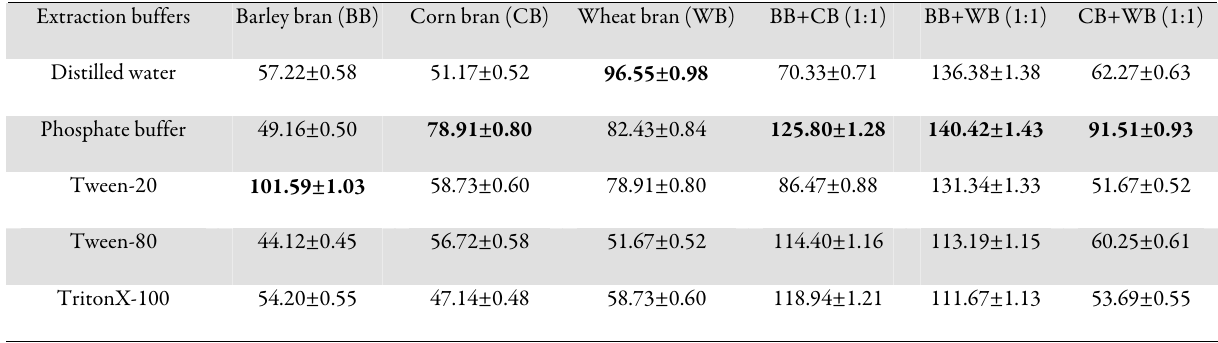
. Mean ± SE of three individual replicates were used for study Different agriculture-residues obtained by local area of Uttar Pradesh and enzymatic activity was quantified based on the amount of reducing sugar (DNS) using starch as